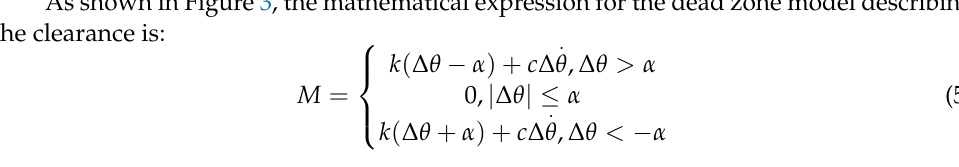
Figure 3. Input and output curve of clearance nonlinear dead zone model.